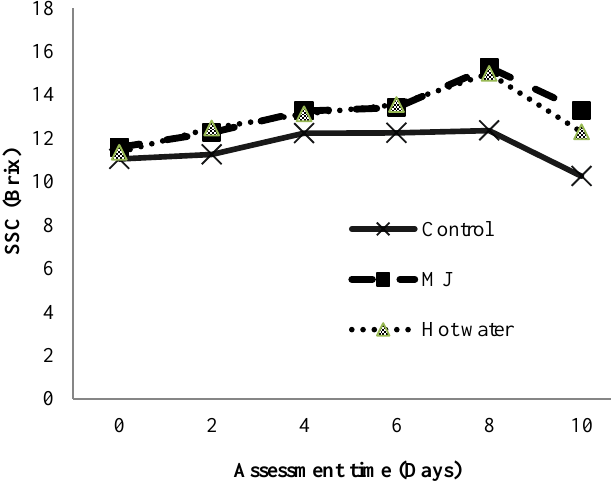
Figure 1. Effects of different postharvest treatments on soluble solid concentration (SSC) of apricot fruits during storage at room temperature (MJ: methyl jasmonic